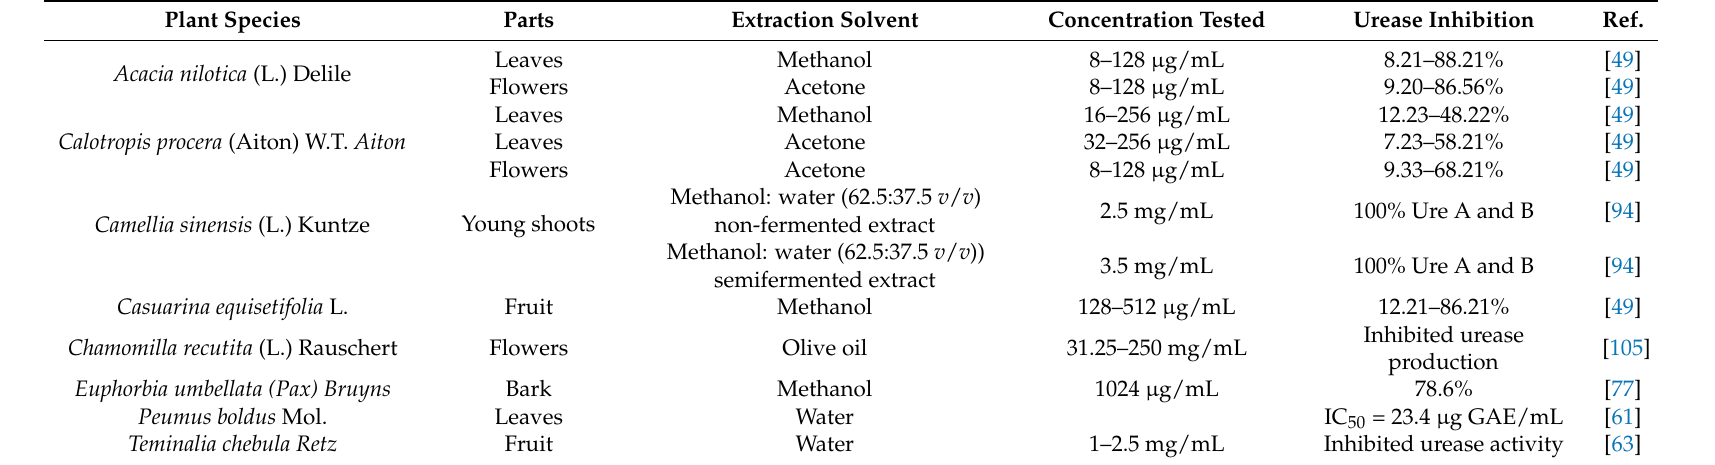
Table 11. Urease inhibitory potential of plant